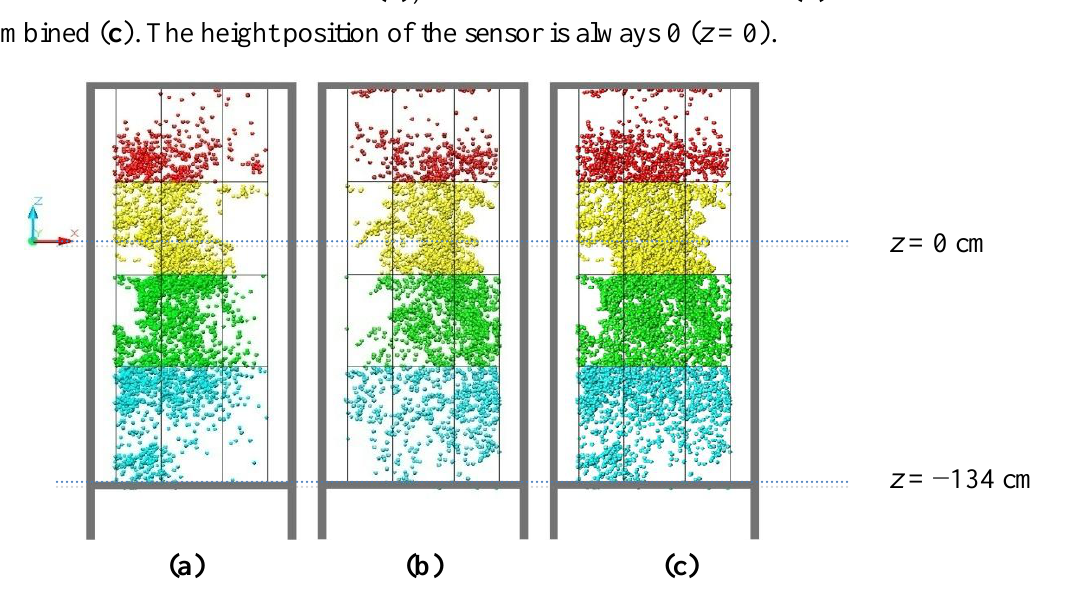
Figure 17. Scatter diagram, regression line and R 2 of the relation between the number of impacts received in the 36 divisions (boxes), combining the front-view (F-05A-05S) and rear-view (R-05A-05S) scans, and the leaf surface area including layer “D” (a) and excluding layer “D” (b)